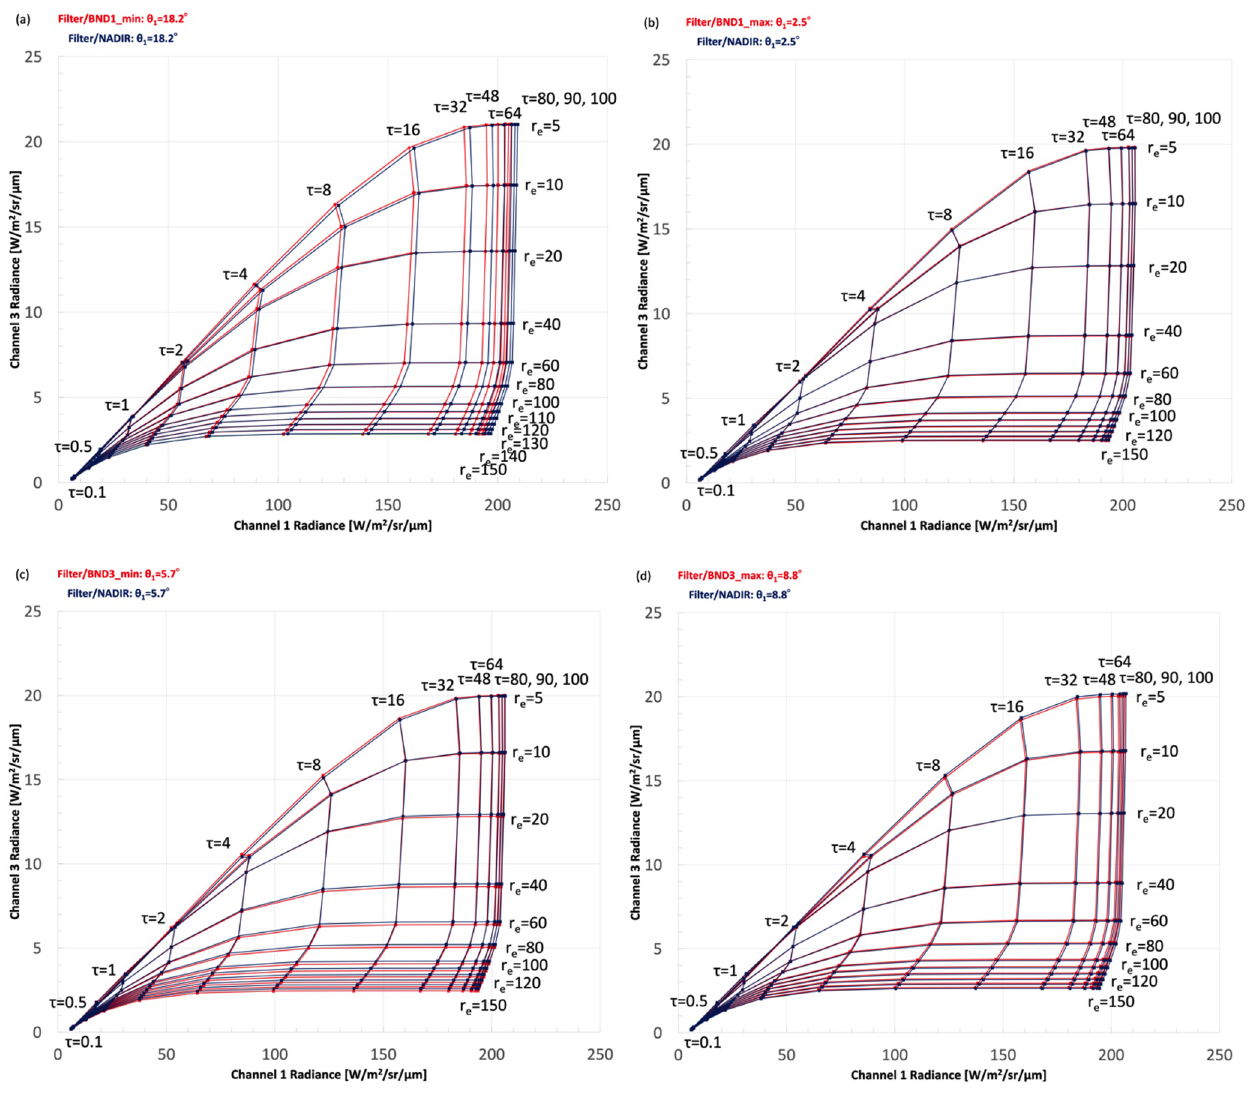
Figure 5. Nakajima–King diagrams for deep convective clouds at (a) pix_BND1_min, (b) pix_BND1_max, (c) pix_BND3_min, and (d) pix_BND3_max for a solar zenith angle of 60 ◦ . The red lines show the results from the response function with SMILE. The black lines show the results from the nadir response